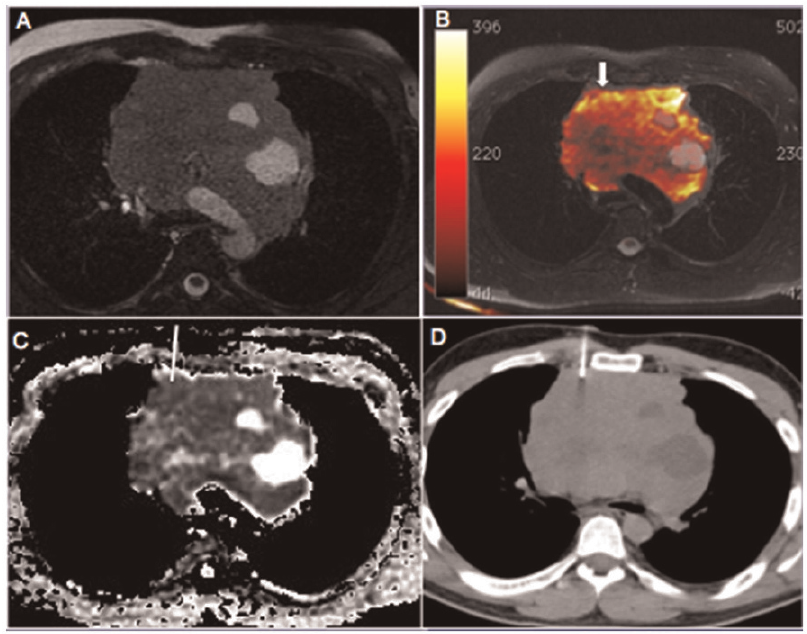
Figure 2 - A 35-year-old man with a large mass in the anterior mediastinum. The mass showed heterogeneous signal intensity on T2- weighted images ( a ) and fused T1- and diffusion-weighted images. ( b ) Note the circumscribed areas of signal hyperintensity suggestive of cysts but also the remarkable signal hyperintensity (arrow) away from the cystic areas near the right anterior lesion margin, with definitive signs of restriction on the apparent diffusion coefficient (ADC) map. ( c ) The ADC value in the target area was 0.61 6 10 -3 mm 2 / s. This mass was subjected to computed tomography–guided biopsy ( d ), and histopathological examination yielded a diagnosis of gray zone